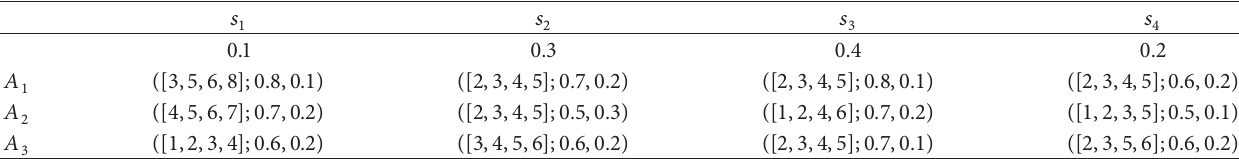
Table 1: Prospect information for attribute 𝑐 1 .